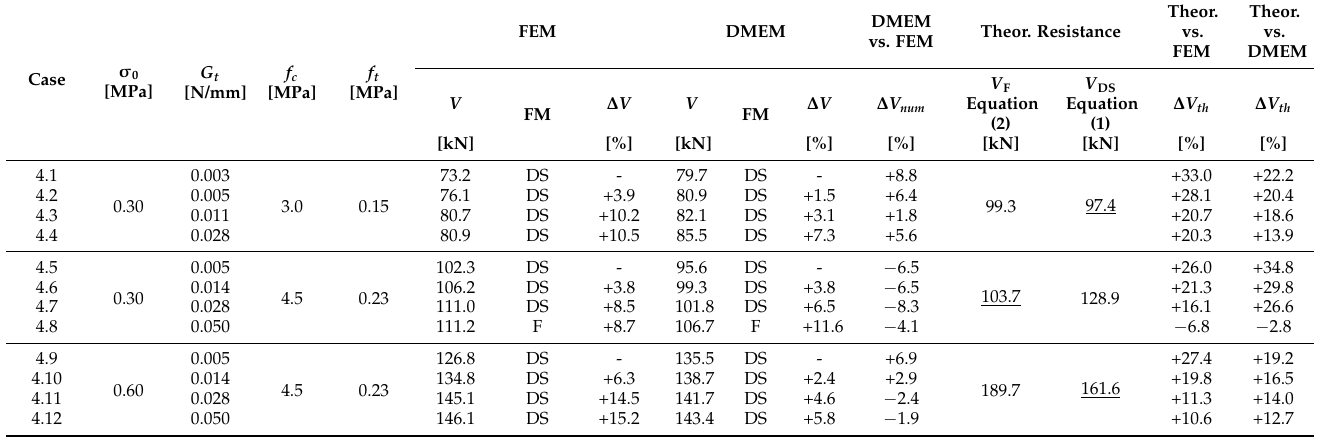
Table 10. Shear resistances of Group